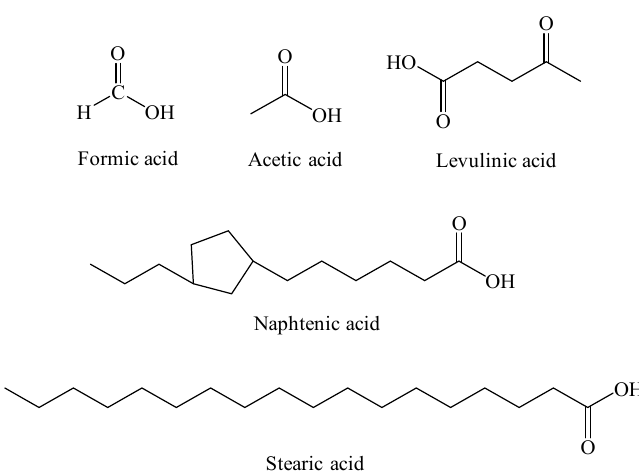
Figure 6. Diagrammatic sketches of acid molecules.